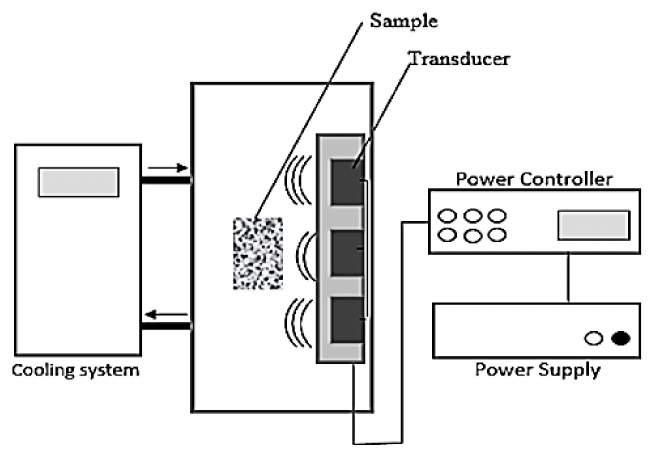
Figure 1. Upper view of ultrasound experimental setup. Table 1. Chemical composition (mass %) of raw sample (soil), before treatment and after 1200 W US (ultrasound) treatment with di ff erent concentrations of